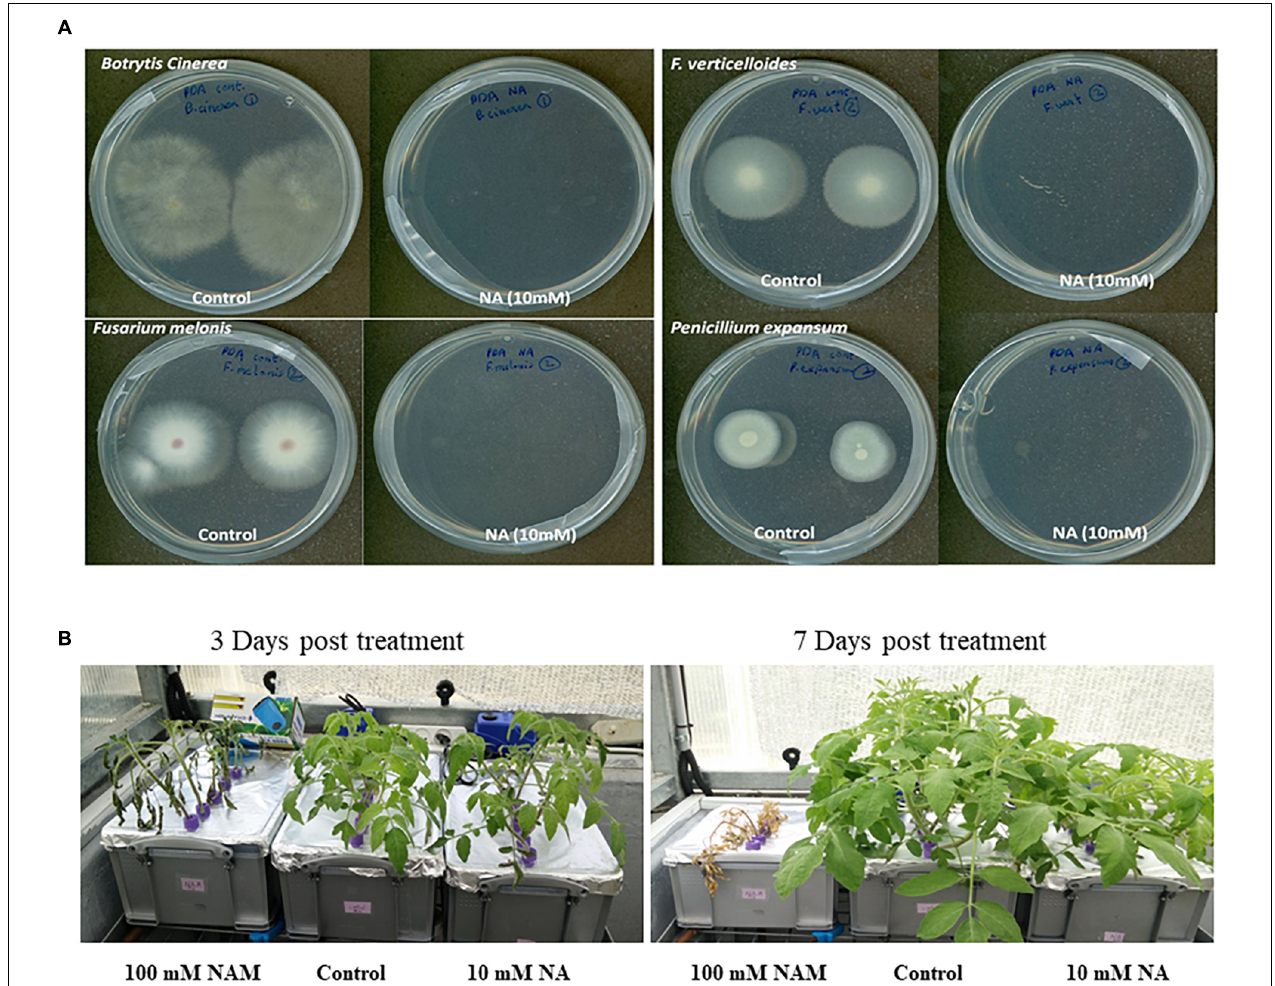
FIGURE 11 | The effect of NA on fungal plant pathogens and tomato plants. (A) Conidia from different plant pathogenic ascomycetes were dropped at the center of PDA plates with or without 10 mM NA. (B) Tomato seedlings were grown for 3 days in water with standard fertilizer in a hydroponic setup. NA and nicotinamide were then added to their final concentration (10 and 100 mM, respectively). The tomato plants were grown for another 8